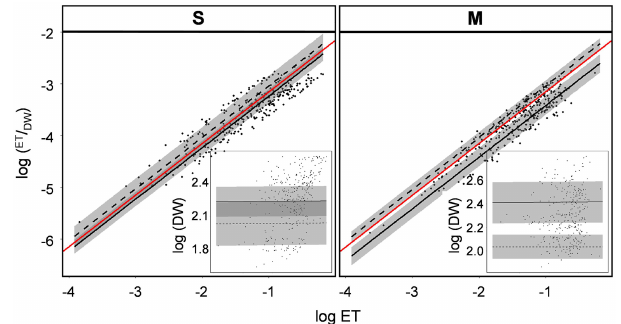
Figure 5. Log–log scaling for the two factors defining variability in ET: ET/DW and DW for the two different vegetation types (S and M; Table 1) subjected to contrasting irrigation regimes (REG – solid lines; D – dashed lines; shaded area – standard deviation); red line indicates a reference function with the slope of 1. X -axes of the subplots have the same limits and units as the corresponding main